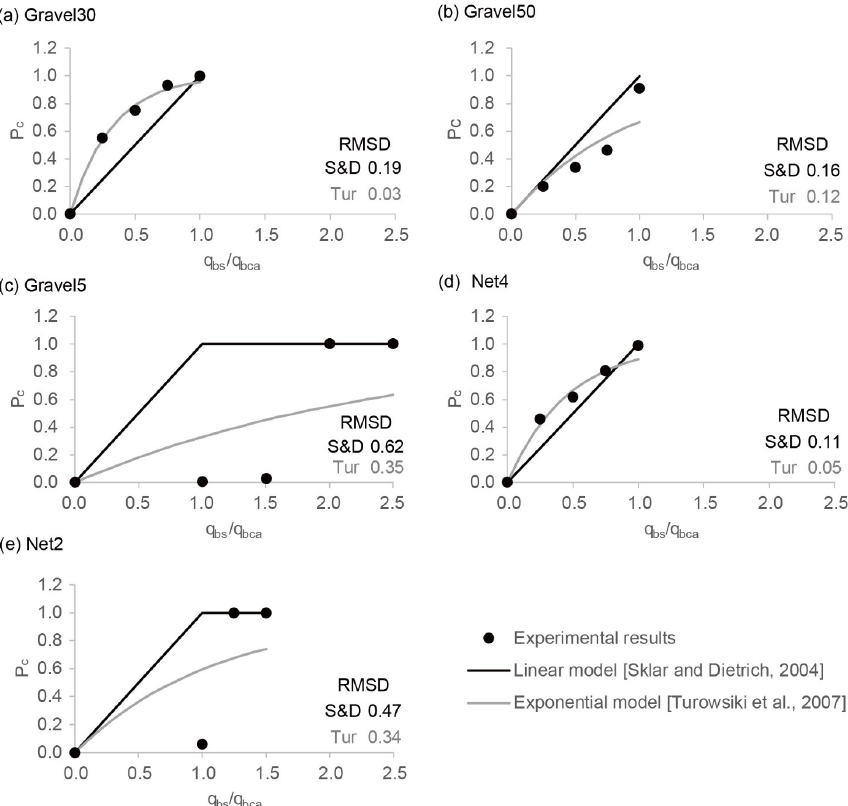
Figure 10. Comparison of our experimental results, the linear model by Sklar and Dietrich (2004), and the exponential model by Turowski et al.